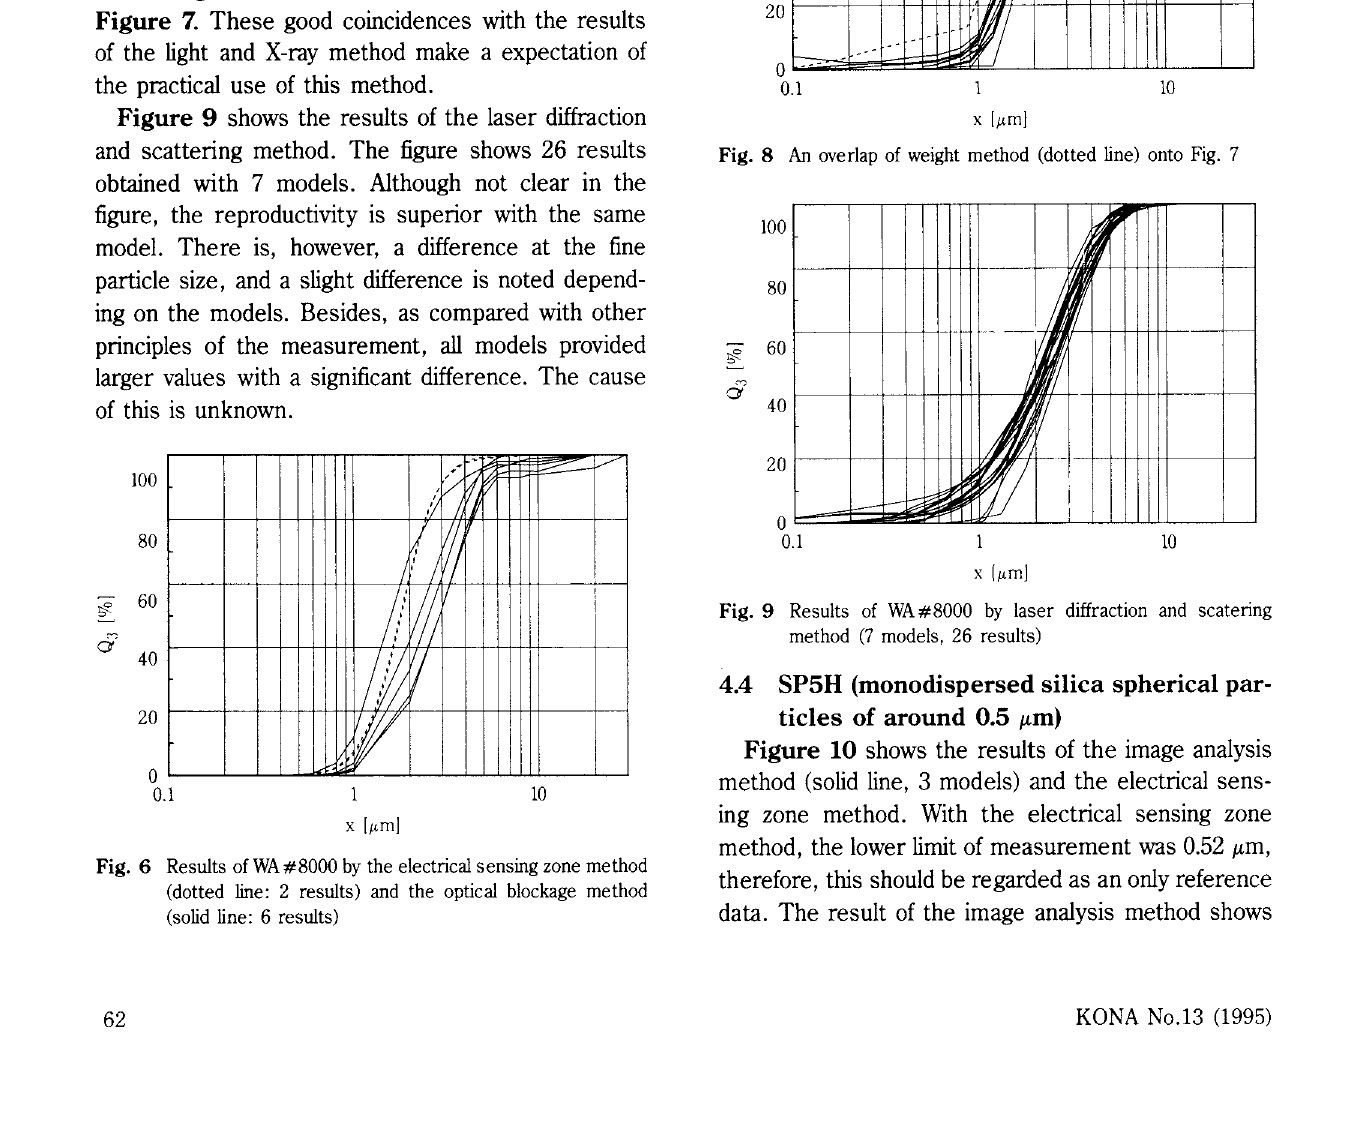
Fig. 9 Results of WA #8000 by laser diffraction and scatering method (7 models, 26